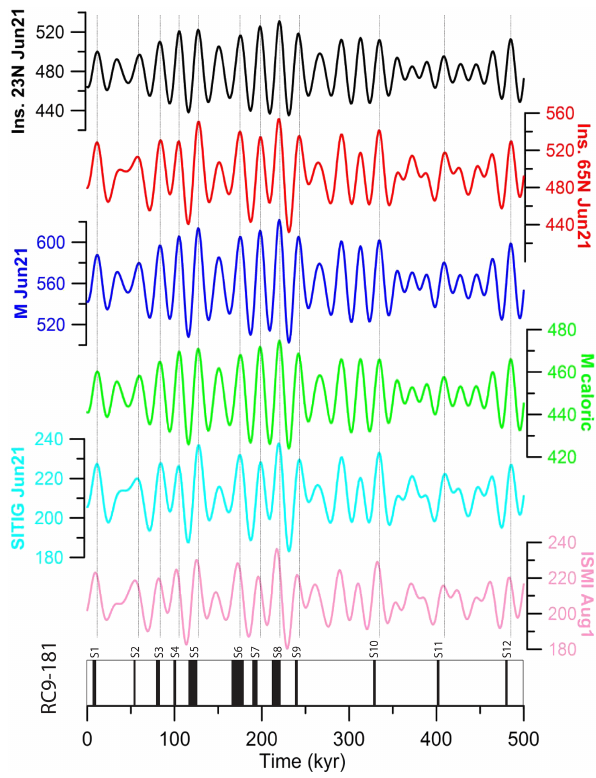
Figure 2. Insolation inWm − 2 over the past 500kyr at 23 ◦ N (black) and 65 ◦ N (red) and insolation indices M (blue, green; Rossignol-Strick, 1985), SITIG (light blue; Reichart, 1996) and ISMI (pink; Leuschner and Sirocko, 2003), based on the astronom- ical solution of Laskar et al. (2004), using AnalySeries (Paillard et al., 1996). All curves are based on 21 June insolation, except M caloric (green, summer half-year) and ISMI (pink, 1 August). The lowest part of the figure shows sapropels in core RC9-181 (Cita et al., 1977; Vergnaud-Grazzini et al., 1977). The vertical lines indi- cate 21 June insolation maxima/precession minima. We note that the obliquity signal also appears in older parts of the insolation and sapropel records (e.g. Lourens et al., 1996; Hilgen et al., 1995, 2003; Zeeden et al.,